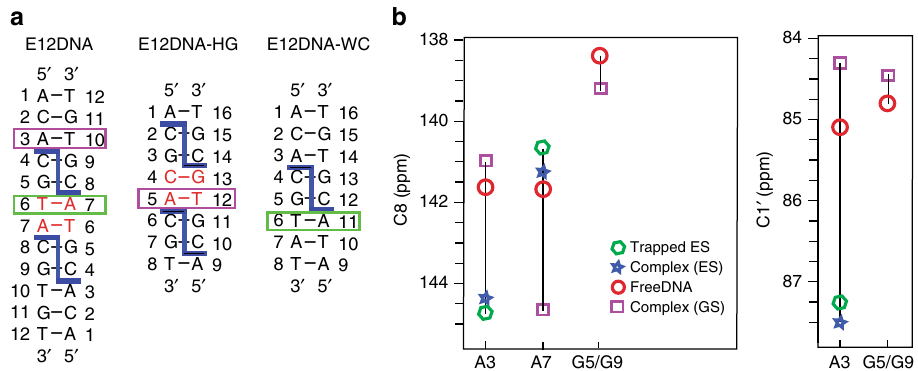
Fig. 3 Chemical shift fi ngerprinting alternative transient states. a DNA constructs used to trap alternative conformations of bps in the parent E12DNA. The stable Hoogsteen bps are shown in red. b Comparison of chemical shifts measured for transient states in the parent complex with those measured for the ground state of the free parent, bound parent, and bound trapped complexes. The RD data for A3C1 ′ were measured at 10 °C for improved